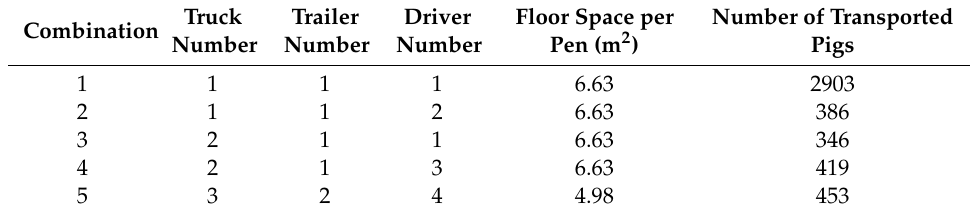
Figure 1. Schematic presentation of the trailer with the numbered trailer pens. Pigs transported: n = 786 in trailer pen 1; n = 1122 in trailer pen 2; n = 1127 in trailer pen 3; n = 896 in trailer pen 4; n = 23 in trailer pen 5; n = 183 in trailer pen 6; n = 334 in trailer pen 7; n = 36 in trailer pen 8. Table 1. Used transport combinations during the